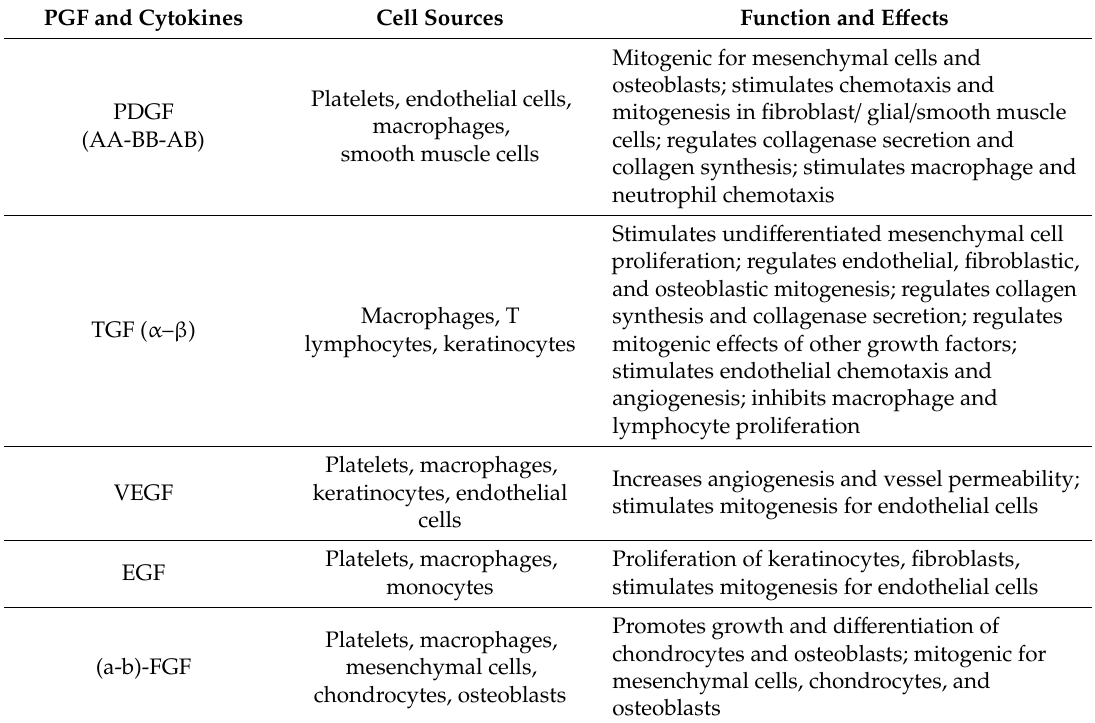
Table 1. Partial list of PRP based growth factors and platelet cytokines with their cell sources. PGF and